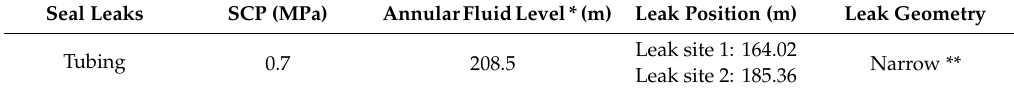
Table 1. Leak parameters of the selected well in the South China